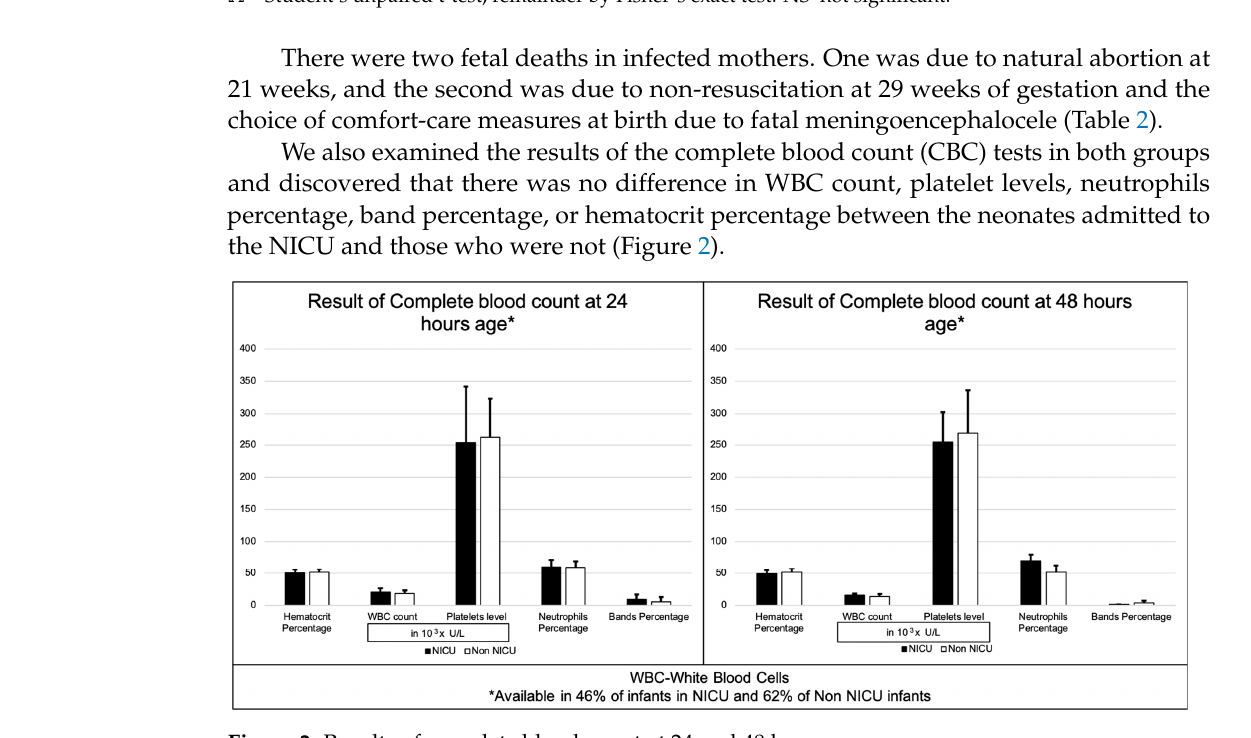
Figure 2. Results of complete blood count at 24 and 48 h.